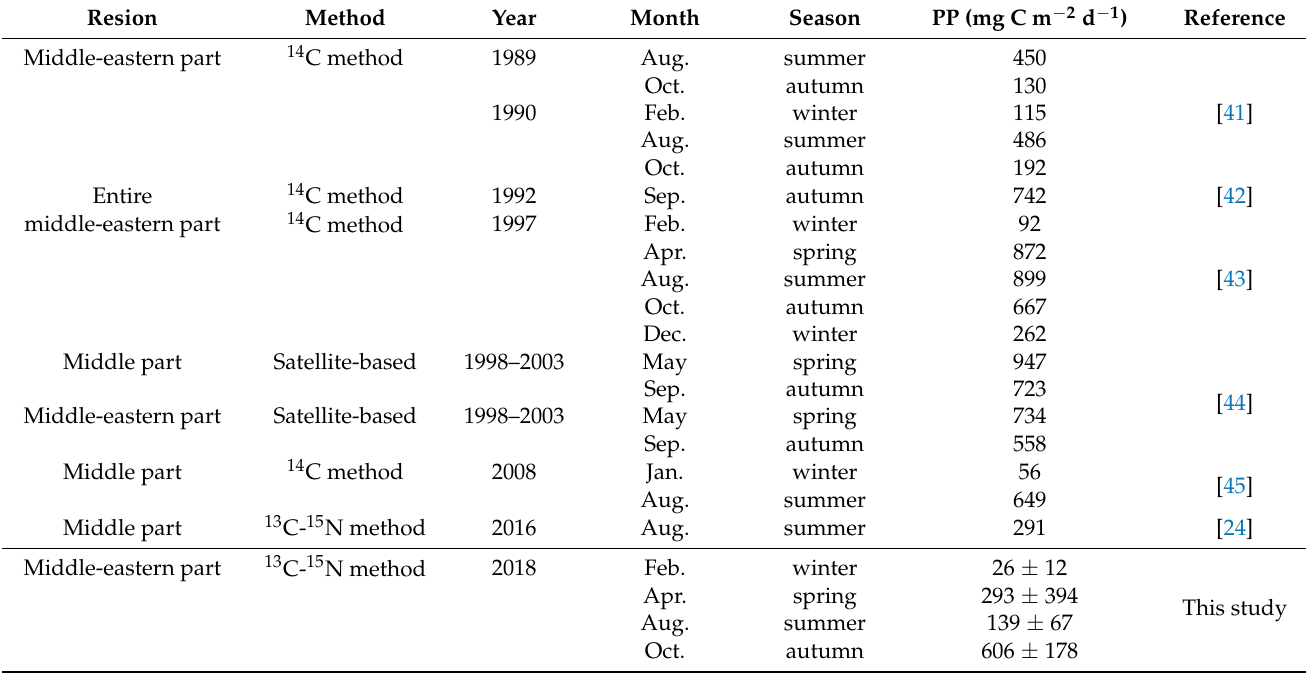
Table 3. Comparisons of daily primary production in the YS. PP represents daily primary production.